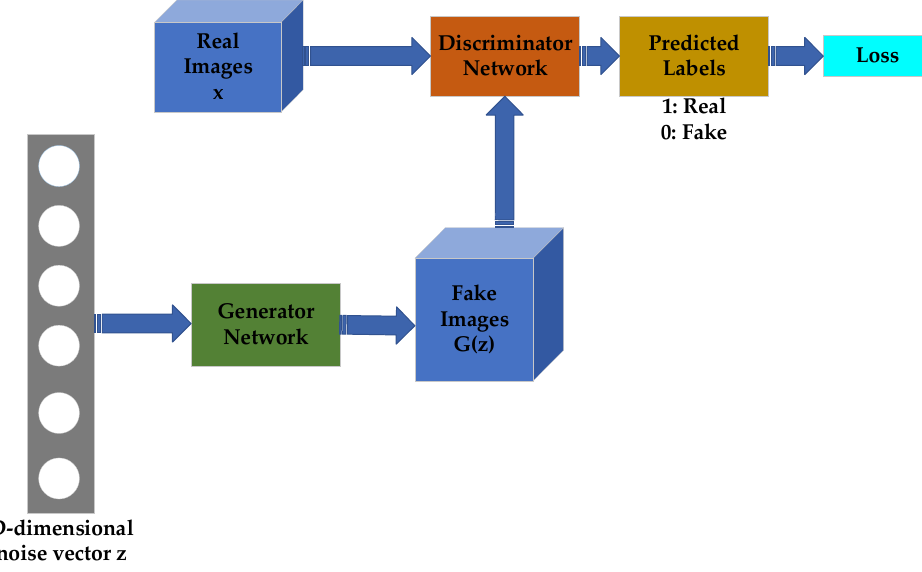
Figure 11. The principle diagram of GAN.